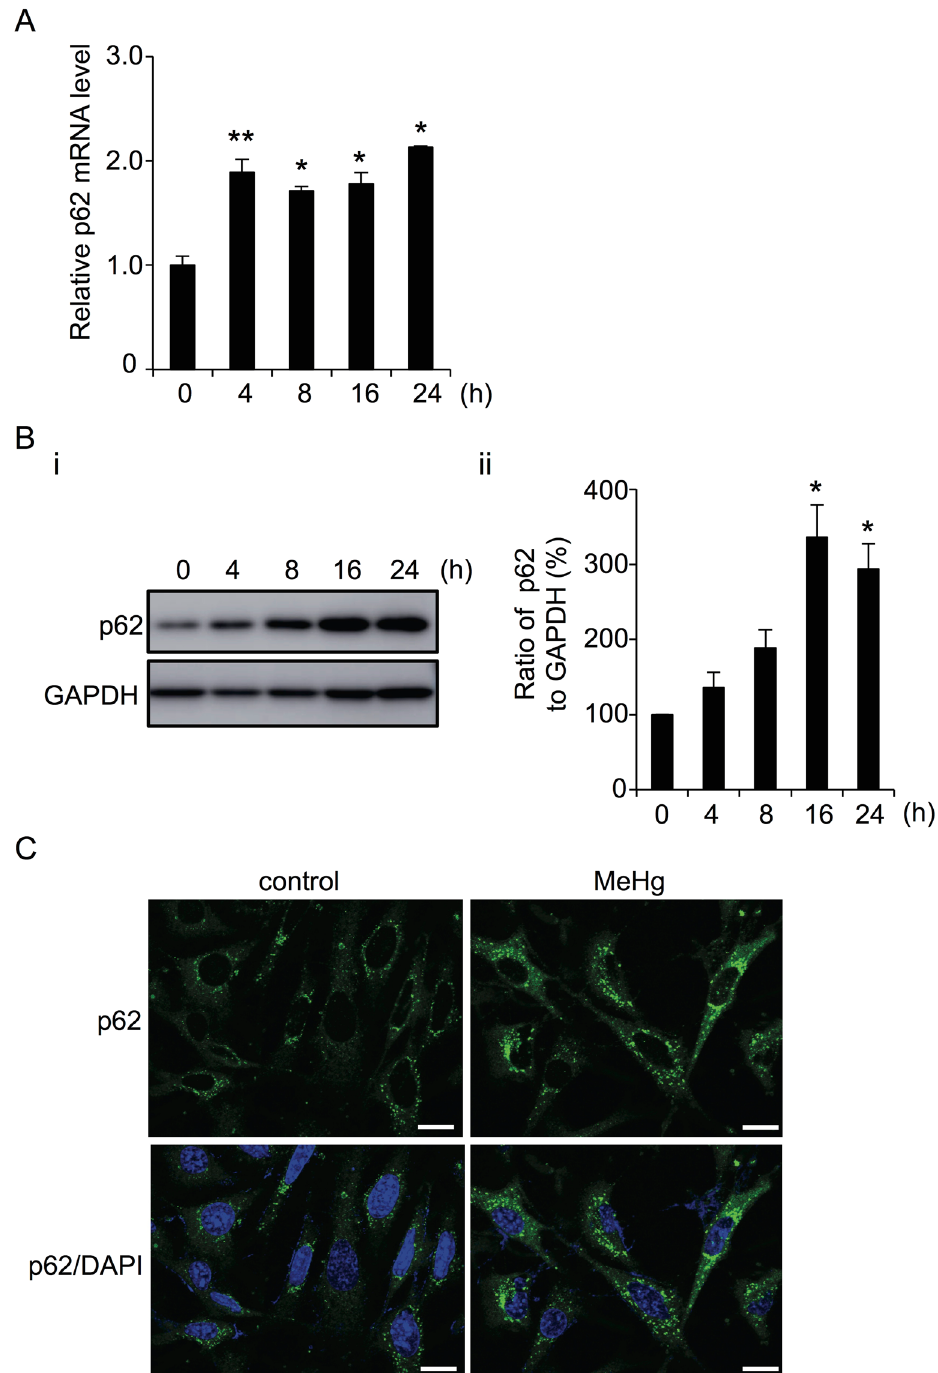
Figure 1. Methylmercury (MeHg) leads to increased p62 mRNA and protein levels in mouse embryonic fibroblasts (MEFs). ( A ) mRNA levels of p62 relative to GAPDH after treatment with 1 µ M MeHg for 0-24 h. Data are expressed as means ± SEM for 3 independent experiments. ** p < 0.01. ( B ) Protein levels of p62 were determined by immunoblotting of cells treated with 1 µ M MeHg for 0-24 h. GAPDH was used as the loading control (i). Blots were quantitated and relative expression values determined (ii). Data are expressed as means ± SEM for 3 independent experiments. * p < 0.05; ** p < 0.01. ( C ) Wild-type (WT) MEFs were treated with or without 1 µ M MeHg for 24 h, and then fixed with paraformaldehyde. Endogenous p62 was immunostained with an anti-p62 antibody. Cells were analyzed with a confocal microscope. Scale bars: 20 µ